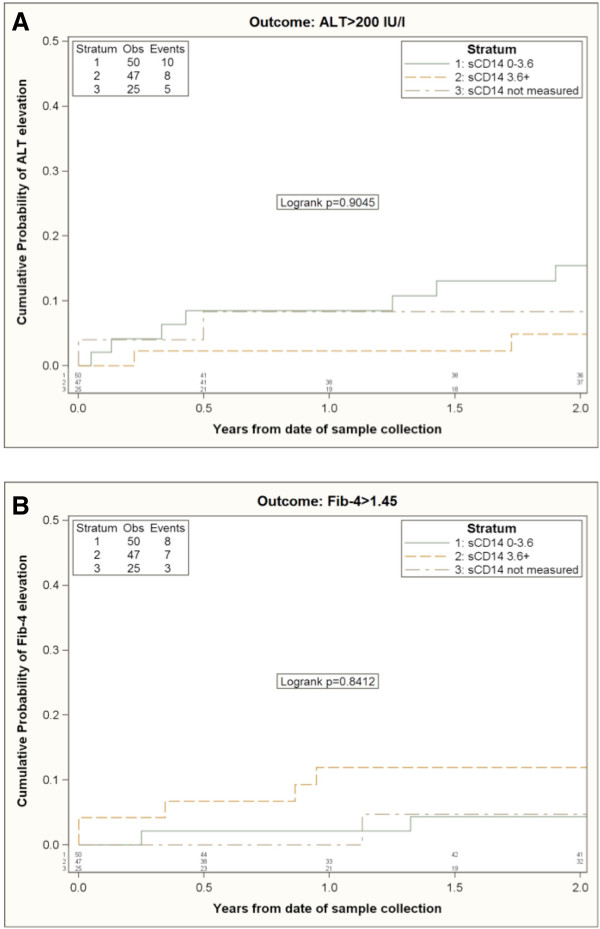
Kaplan-Meier estimates of the risk of ALT elevation (A) and Fib-4 elevation (B) according to sCD14 strata. Kaplan-Meier plots were used to compare the cumulative percent of patients reaching the primary endpoint. The cohort was stratified according to sCD14 plasma levels above or below the median (i.e. 3.6 pg/ml).